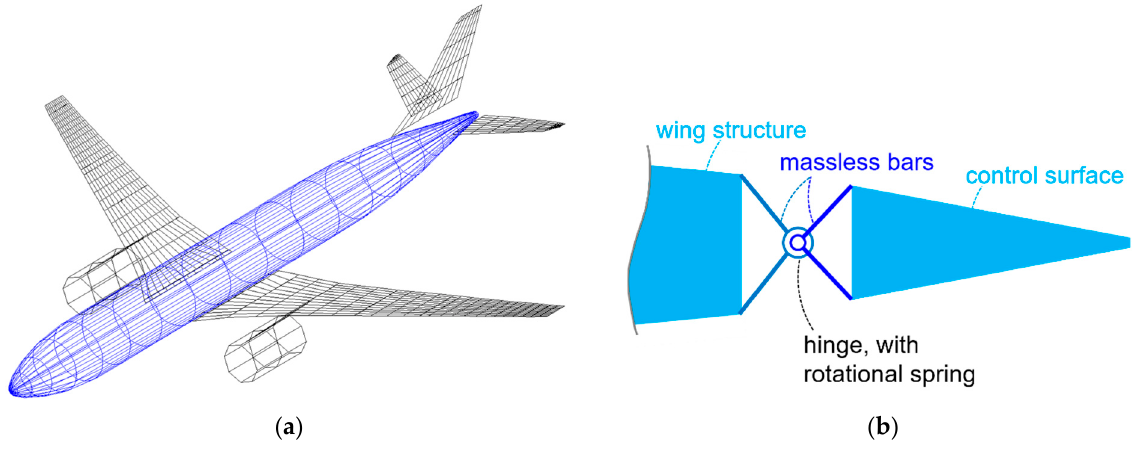
Figure 6. Aerodynamic model of the XRF1-DLR-C ( a ) and principal sketch of the hinge model ( b ). The structural models of the control surfaces were created using ModGen and these were connected to the wing structure using massless bar elements, while a hinge spring of 1 Nm/rad was defined to avoid a stiffness singularity. Furthermore, the corresponding DLM boxes were assigned to the control surface to reproduce its deflection, and the aerodynamic effectiveness was set to 1.0. Figure 6b shows a principal sketch of the hinge. For the introduction of the landing gear loads, a simplified model using massless bars was applied. The massless bars connected the nodes which represent the tire positions and nodes on the aircraft. For the nose gear, the bar representing the main strut was connected to the nearest fuselage node, while the bar representing the side stay was connected to a fuselage node further forward. For the main gear, the main strut was represented by two bars which connected the landing gear node with the nearest wing LRA and the corresponding trailing edge node, respectively. This was completed to enable a transfer of the torsion moments from the landing gear into the wing since the bar elements in MSC.Nastran are not designed to transfer moments. Analogously, the side stay was modeled with two bars which were connected to an LRA and its corresponding trailing edge node further inboard. The bar elements for the main strut were set to a stiffness equivalent to an aluminum rod with a 10 cm diameter, while those for the side stay had an equivalent rod diameter of 5 cm. Figure 7 visualizes the simplified landing gear modeling; the blue bars represent the main struts, and the green ones stand for the side